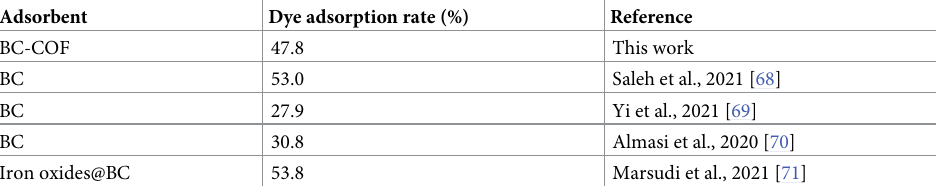
Table 4. Maximum dye adsorption rate (%) for various BC derived adsorbents for methylene blue dye adsorption. Adsorbent